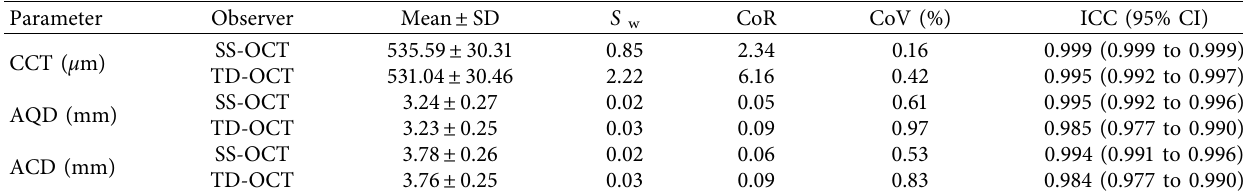
Table 1: Intraobserver repeatability outcomes provided by SS-OCT and TD-OCT devices. Parameter